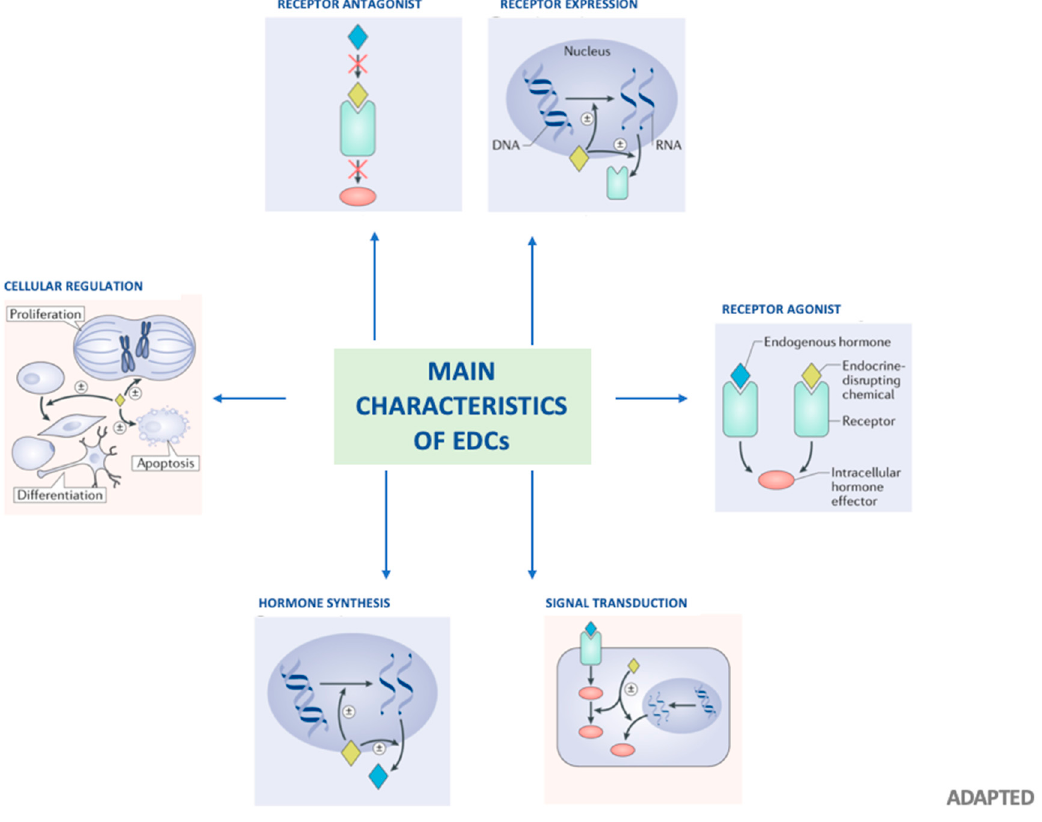
Figure 1. Main features of EDCs, Adapted by Michele A La Merill et al., Nature Reviews 2020 [19]. Arrows identify the main characteristics of EDCs. The ± symbol indicates that an EDC can increase or decrease processes and effects. EDC can interact with or activate hormone receptors, antagonize hormone receptors, alter hormone receptor expression. Furthermore, EDC can alter the fate of hormone-producing or hormone-responsive cells. Alter hormone synthesis and cellular regulation.